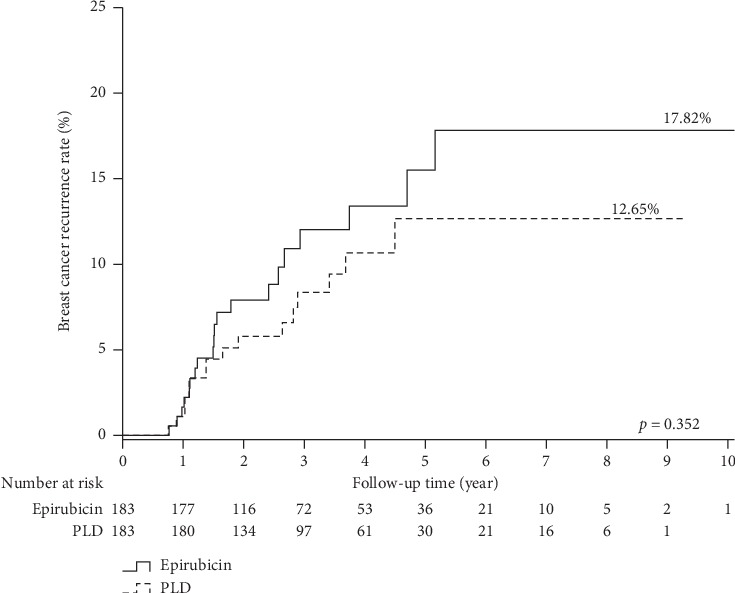
Cumulative recurrence estimates of breast patients treated with PLD versus epirubicin neoadjuvant chemotherapy.